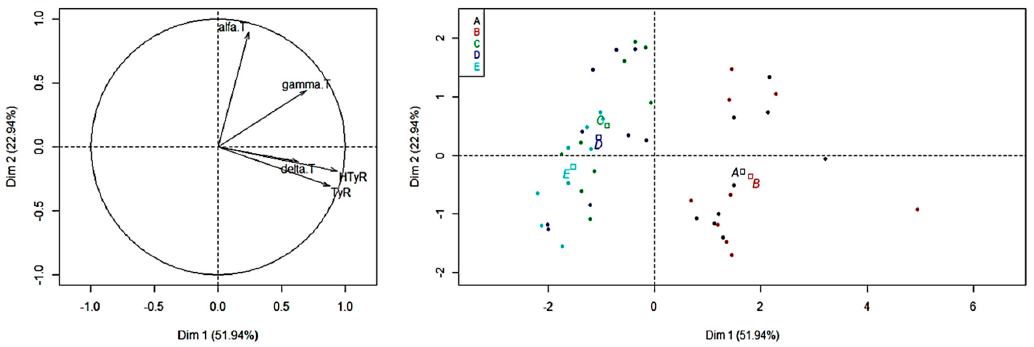
Figure 3. Principal component analysis (PCA) of phenolic compounds and tocols in oil samples across the refining procedure. ( a ) Loading plot of the variables; ( b ) Score plot of the samples. Legend. A: Crude oil; B: degummed oil; C: neutralized oil; D: bleached oil; E: deodorized oil; alfa T: α -tocopherol; gamma T: γ -tocopherol; delta T: δ -tocopherol; HTyR: hydroxytyrosol; TyR: tyrosol.